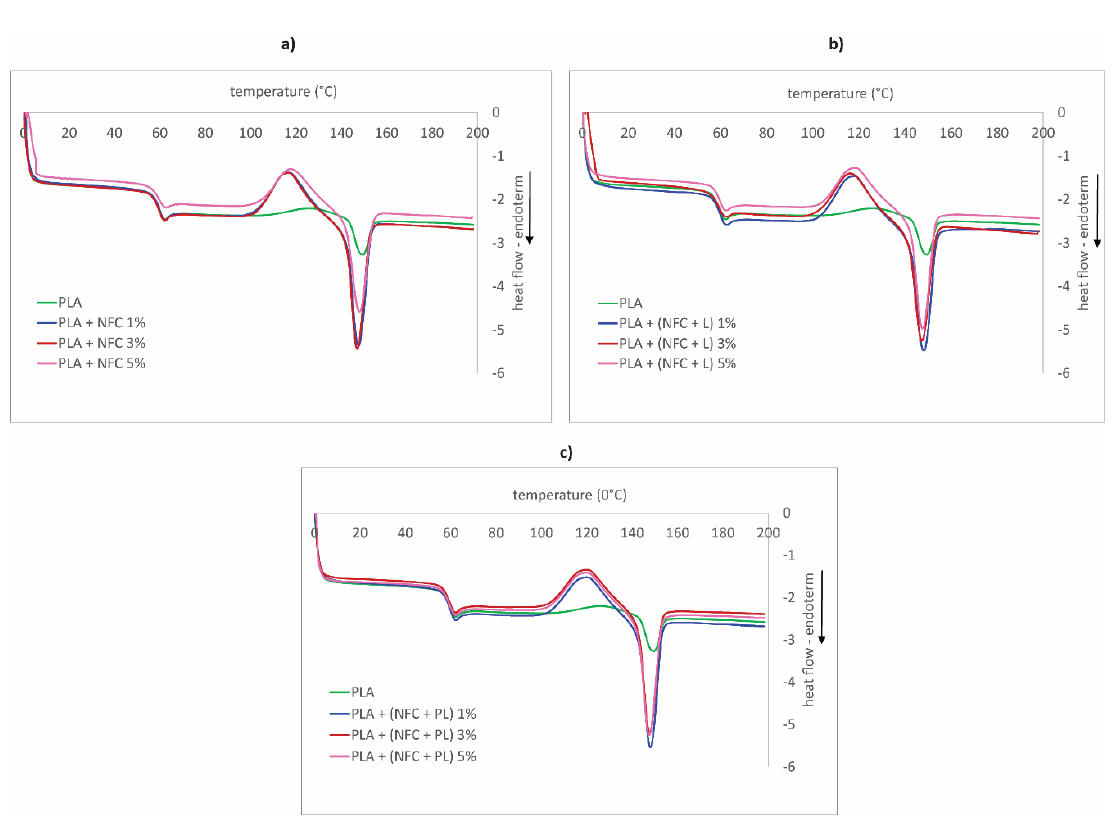
Figure 12. DSC second heating curves of samples in groups ( a ) GR1, ( b ) GR2, and ( c ) GR3. As shown in Figure 7, the DSC curves indicated the three temperature transitions, which were typical for PLA polymer: the glass transition, the cold crystallization peak, and the melting peak. The area of the glass transition was located approximately at 60 °C (Figure 12), which was not in correlation with the glass-transition temperature indicated by the DMA analysis (Section 3.5). Since the DMA method was a more sensitive and suit- able method for determining the glass-transition temperature, its results were more rele- vant. However, as in the case of the DMA analysis, it could be confirmed that NFC, lignin,